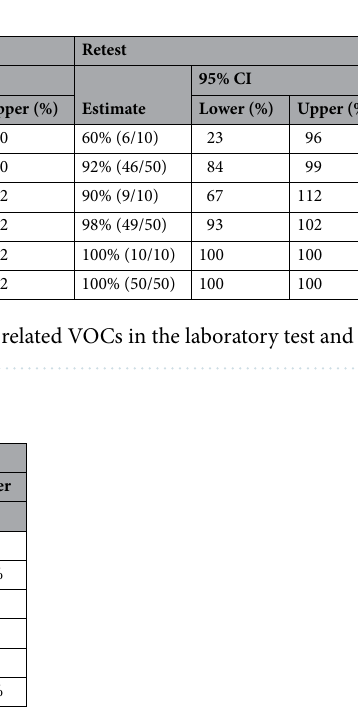
Table 2. Measured and simulated overall positive predictive values (PPVs) and negative predictive values (NPVs) with 95% confidence intervals.